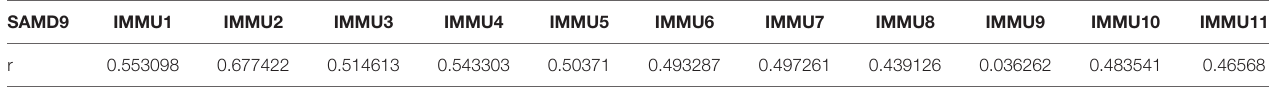
TABLE 3 | SAMD9 and related immune scores in CGGA database 1 LGG.